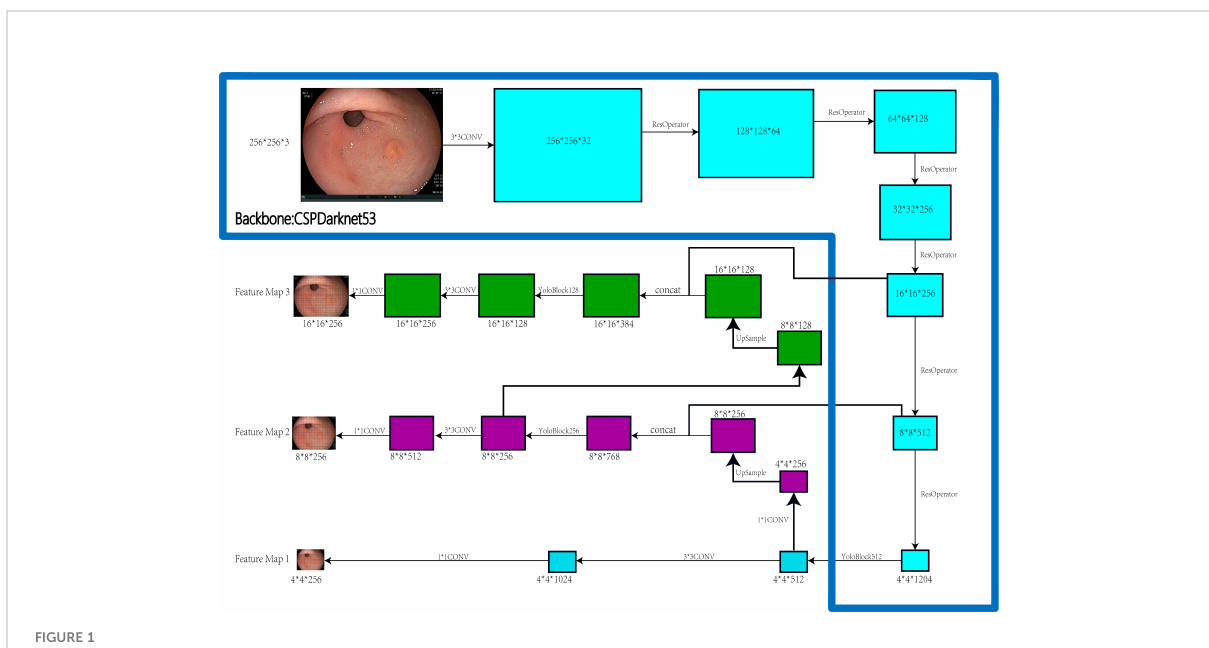
FIGURE 1 Steps and Architecture for